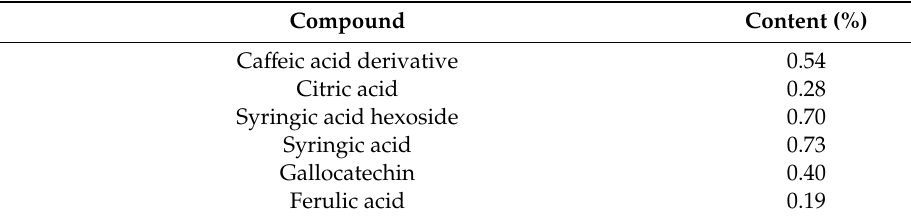
Table 1. Qualitative and quantitative content of Ephedra alata Decne extract